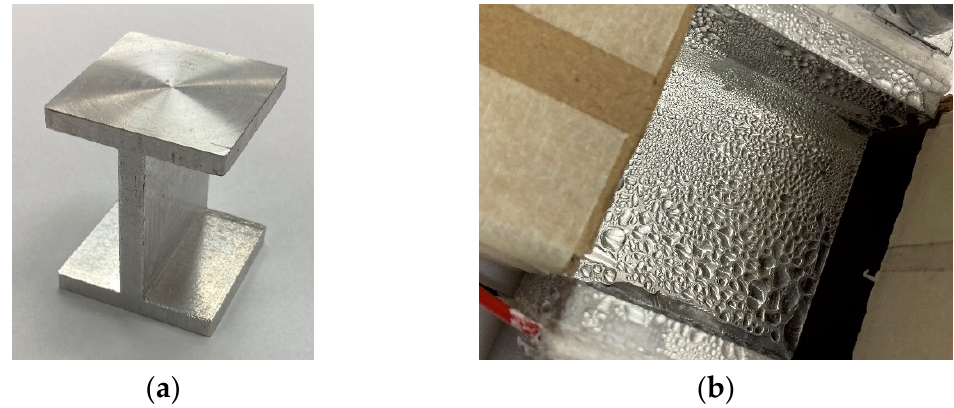
Figure 9. Prototype heat sink (a) heat sink before the installation; (b) condensation on heat sink.